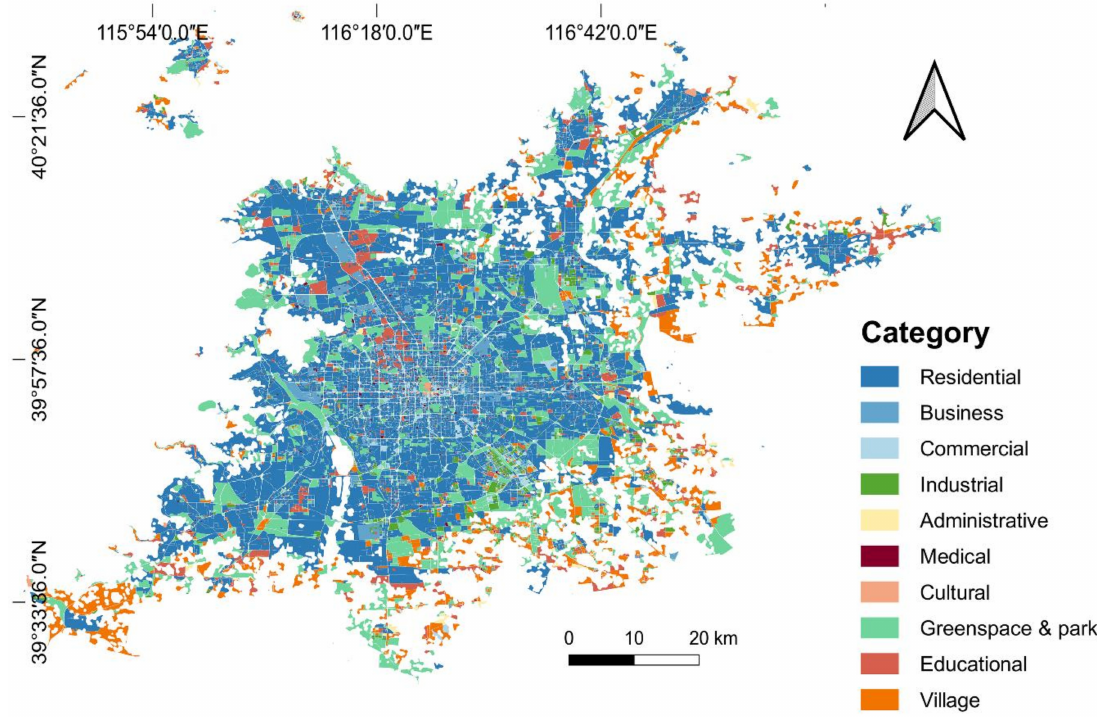
Figure 8. Map of EULUC-AOI (OSM) in Beijing,